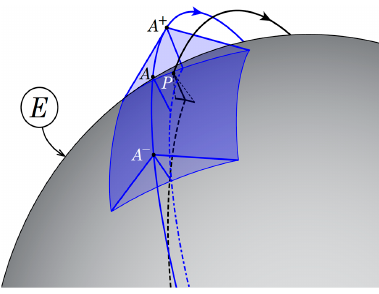
Figure 3. MIIC LEO-LEO event prediction tent structure.